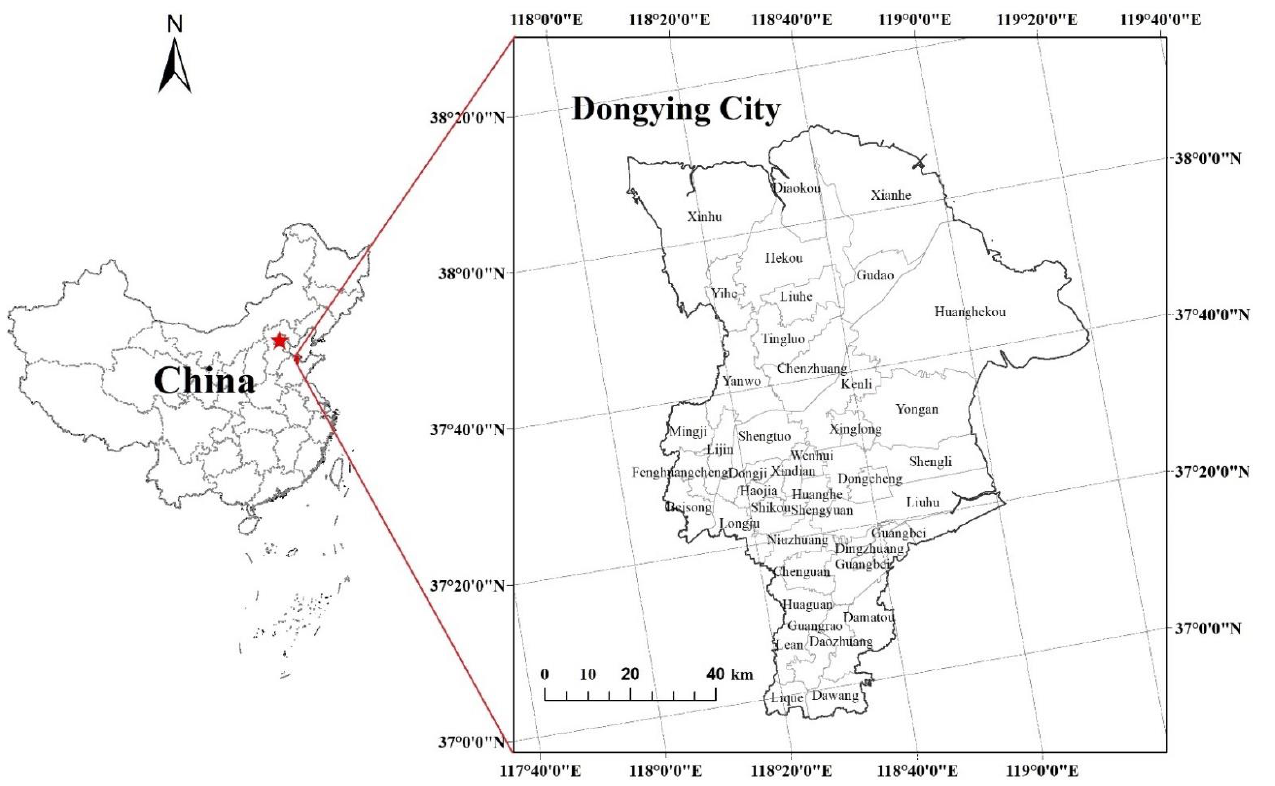
Figure 1. Geographical location of Dongying.